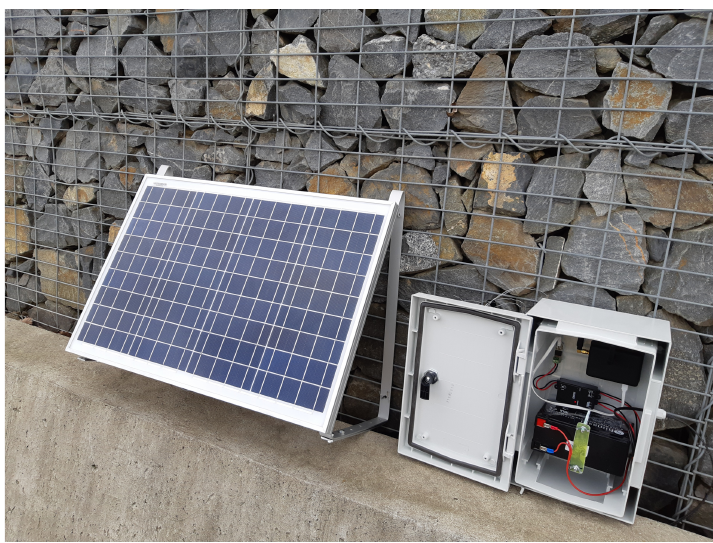
Figure 15. Image of the IQRF R (cid:13) /GSM gateway and solar panel installed on the gabion